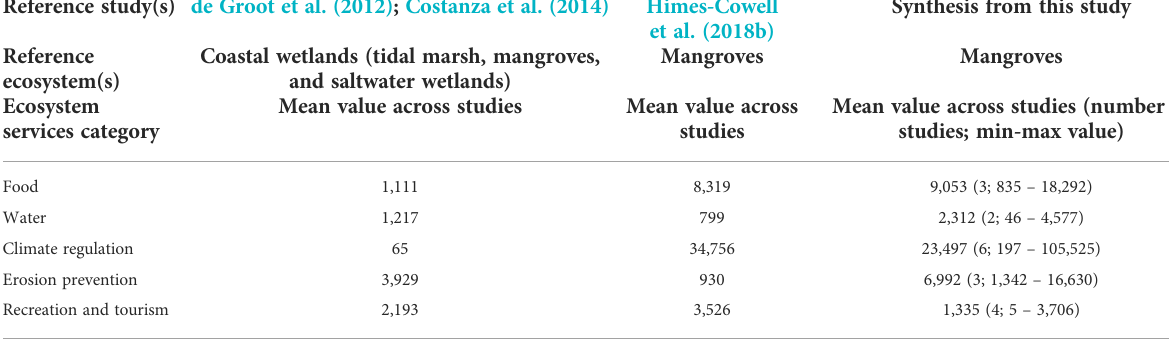
TABLE 3 Comparisons of the mean estimated value of ecosystem services in Malaysia with global